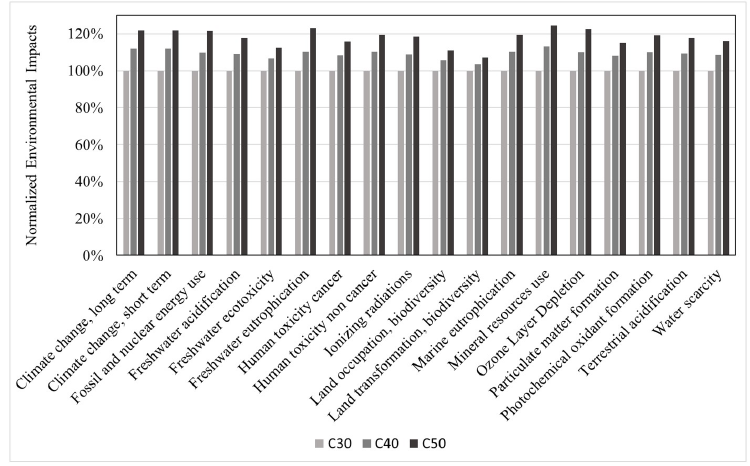
Figure 3. Normalized LCA results for 1 m 3 of concrete